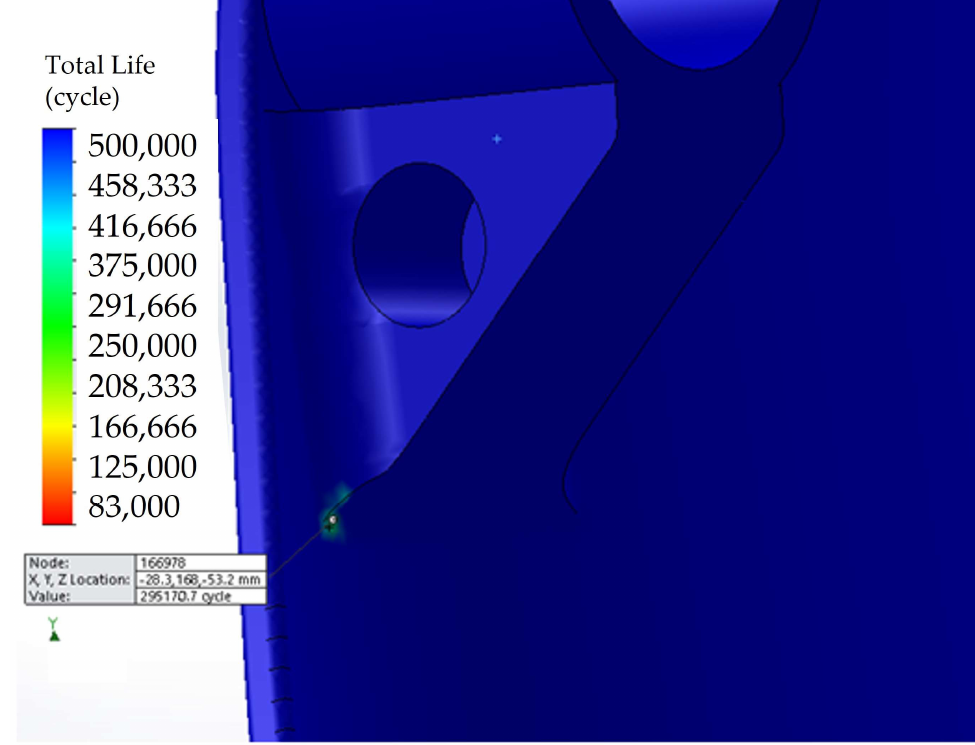
Figure 14. Close-up of the cycle number map for the housing failure.